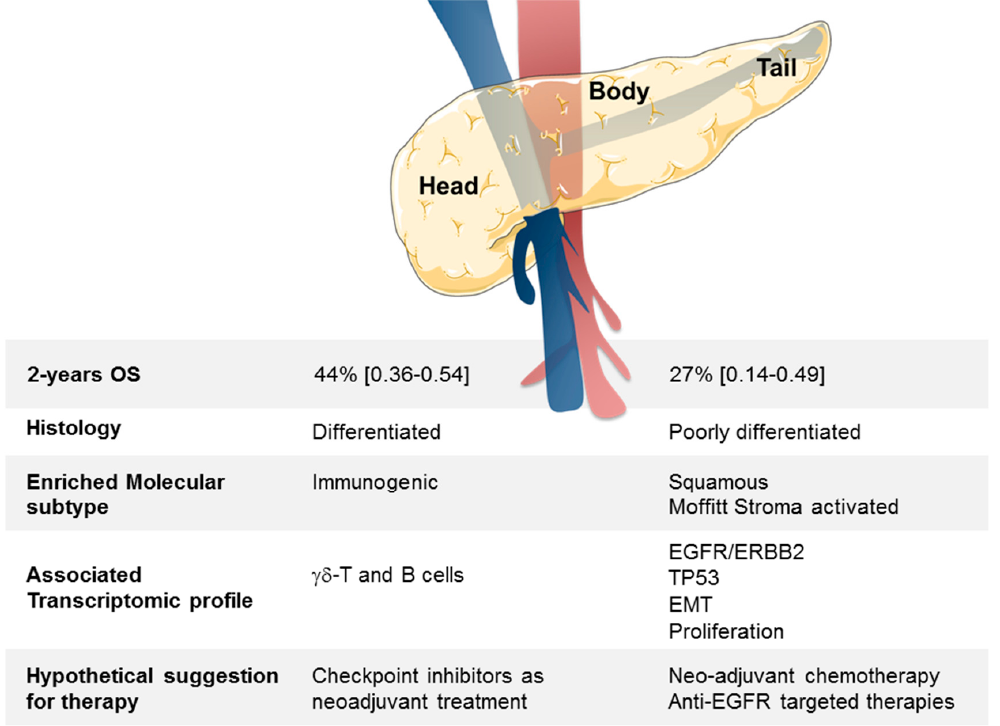
Figure 4. Summary of clinical, histologic, and molecular differences between head and B/T PDAC tumors. Supplementary Materials: The following are available online at www.mdpi.com/xxx/s1Table S1: List of pancreatic cancer data sets included. Table S2: List of 334 genes differentially expressed between head and B/T location of PDAC. Table S3: Ontology analysis of the 334 genes differentially expressed between the head and B/T location of PDAC. Table S4: Enrichment for cell types and or oncogenic pathway activities in “head” vs. “body/tail” samples. Figure S1. Principal component analysis performed before and after normalization of the 4 data sets.